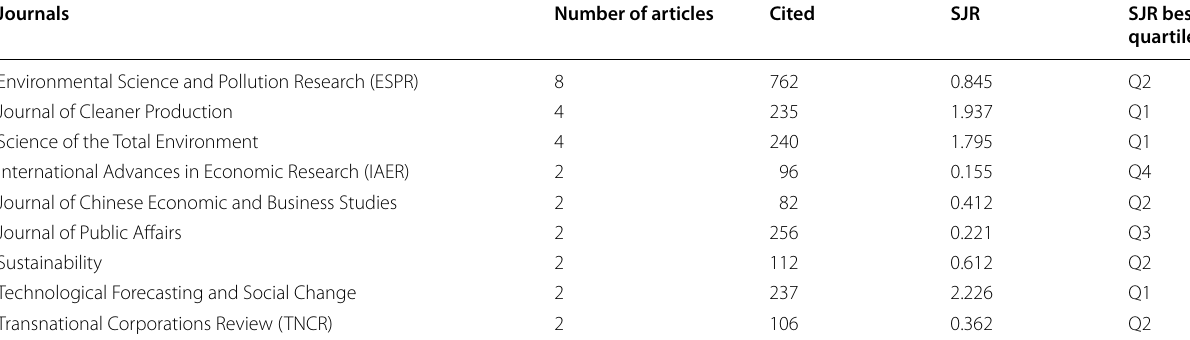
Table 2 Specialized journals for future research on regional sustainable